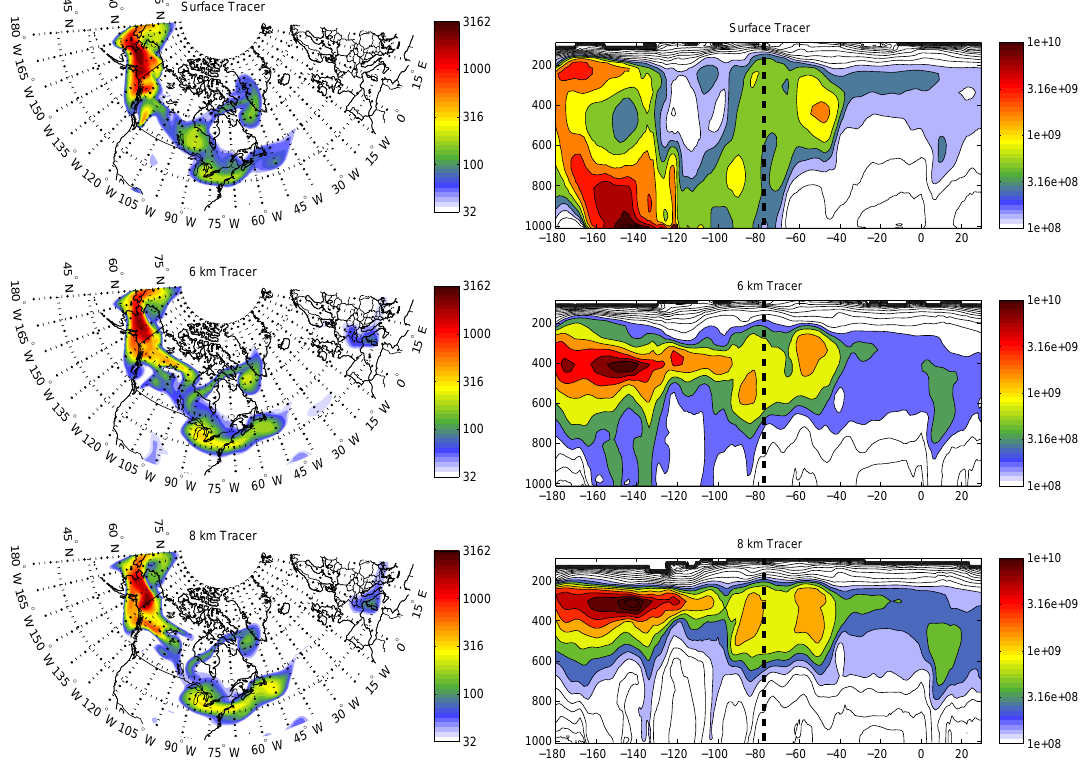
Fig. 13. 30 June 2004 15:00UTC: left plots show tracer burdens in mgm − 2 . Right plots are vertical longitudinal cross-sections of the tracers averaged from 30 ◦ N to 80 ◦ N in kgkg − 1 × 10 15 . Top, middle and bottom plots correspond to the surface, 6km and 8km tracers, respectively. The thick black dashed vertical line represents the location of Washington ( − 77.5 ◦ W). Scales are